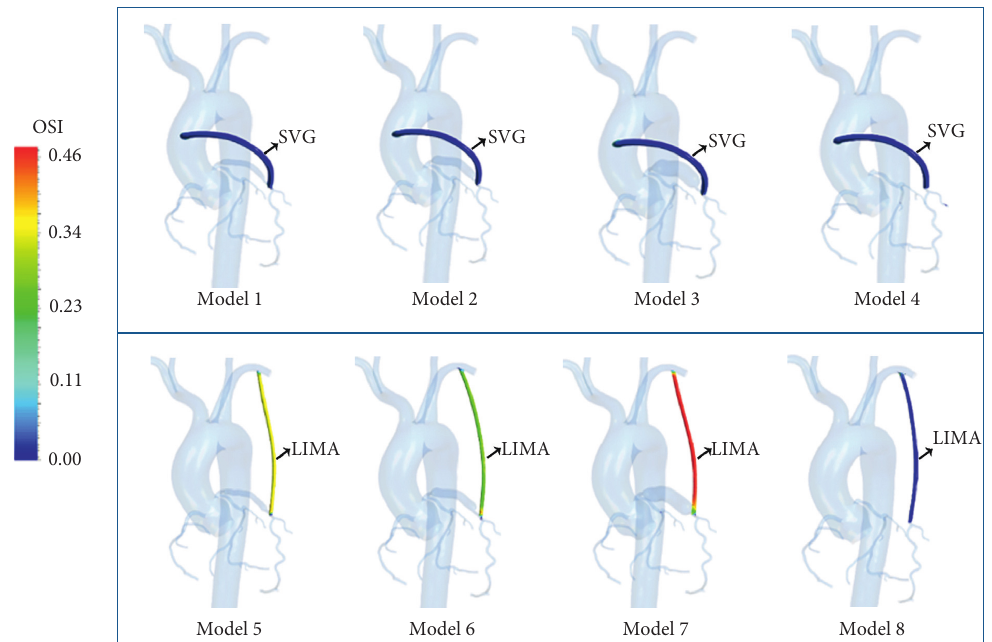
Figure 6: The OSI distribution on the bypass grafts (SVG and LIMA) in a cardiac